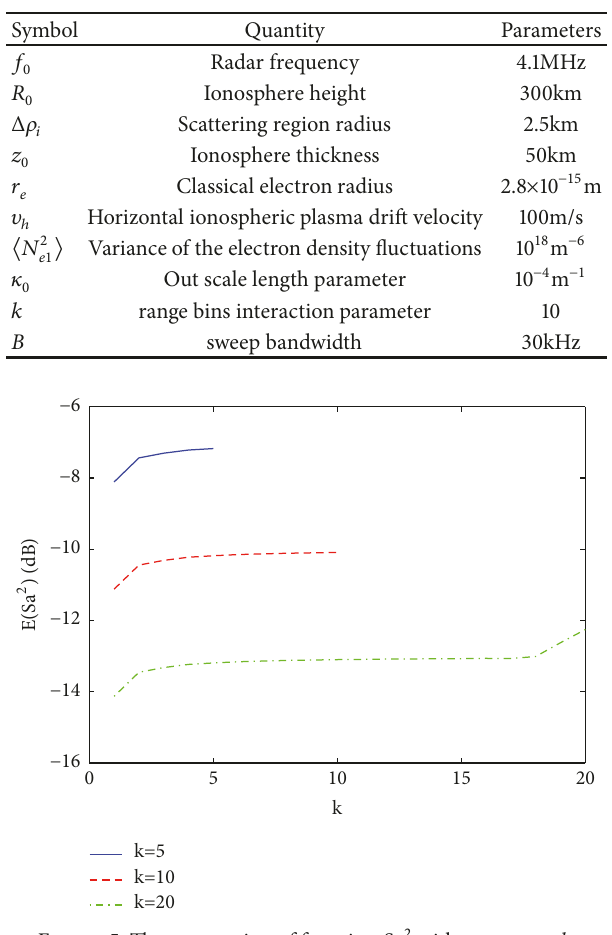
Figure 5: The expectation of function Sa 2 with parameter k